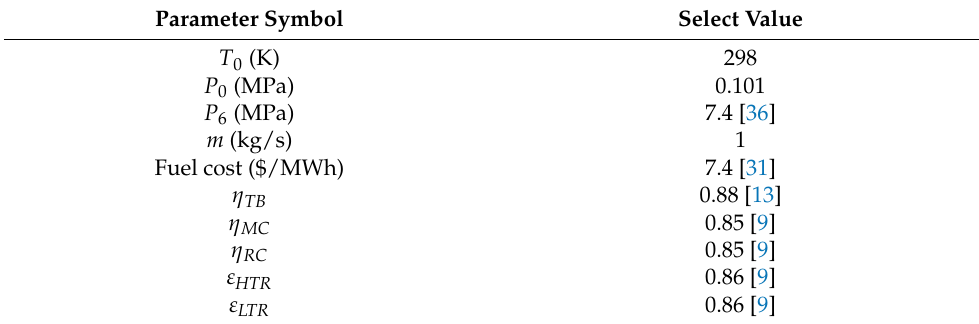
Table 3. Basic parameters selected in simulation.